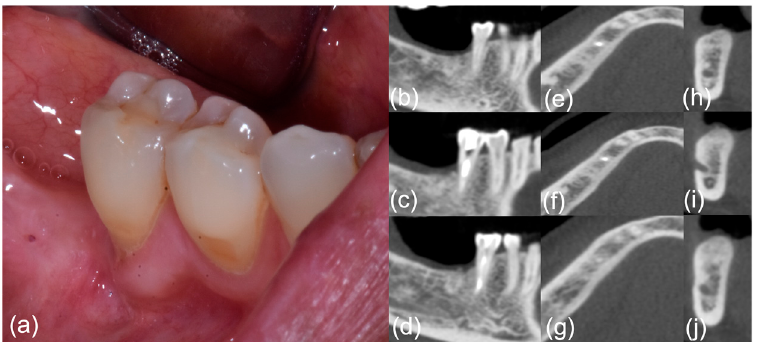
Figure 2. Patient #6, post-treatment phase; right-side mandibular MRONJ: ( a ) clinical view; ( b – j ) computed tomography scan sections.